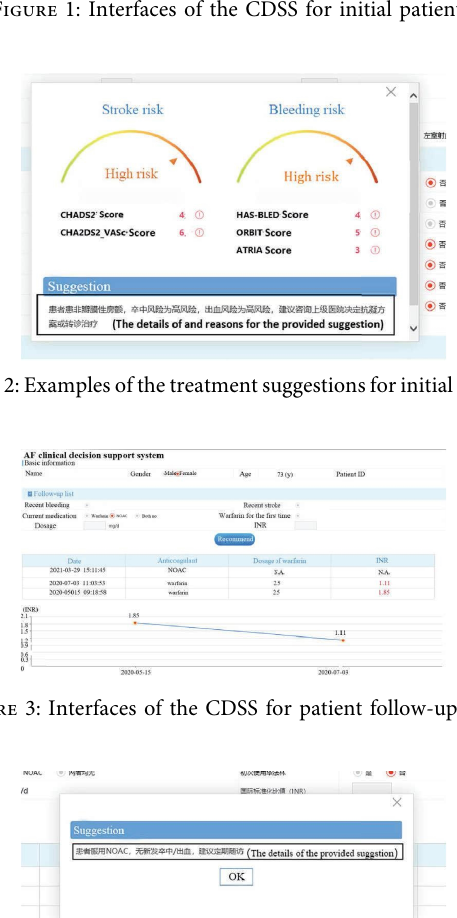
Figure 1: Interfaces of the CDSS for initial patients.